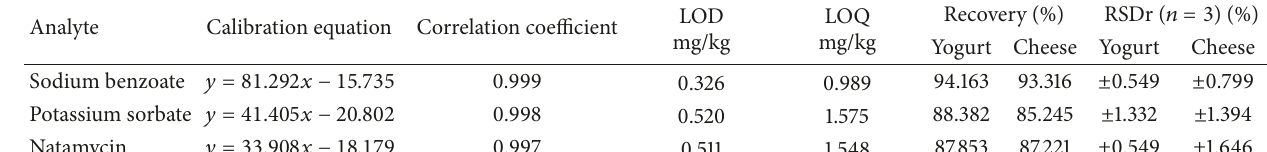
Table 1: Analytical characteristics of the method validation.